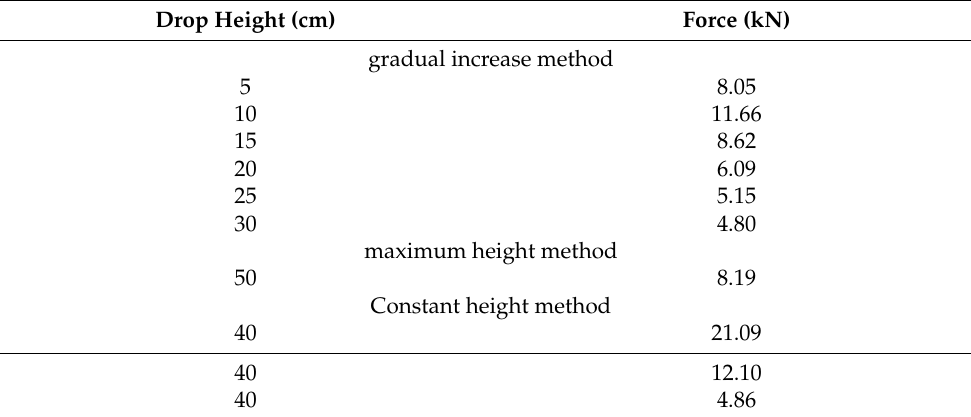
Table 3. Data from the masonry of ceramic blocks